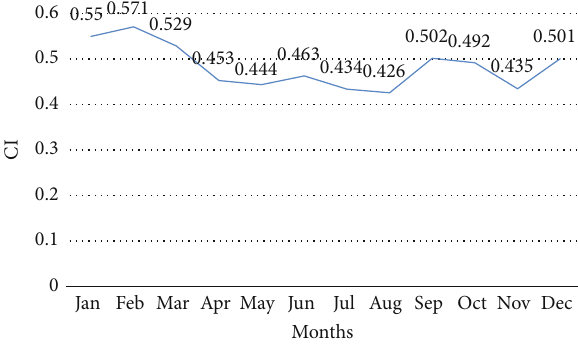
Figure 26: Monthly clearness index (CI) for Tanzania.